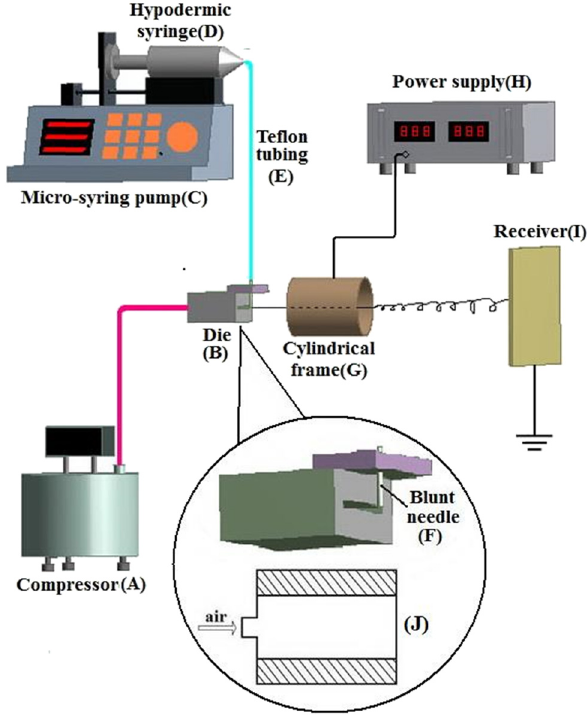
Figure 1: Schematic of CSBS setup ( 25 ) : ( A ) compressor, ( B ) die, ( C ) micro - syringe pump, ( D ) hypodermic syringe, ( E ) te fl on tubing, ( F ) blunt needle, ( G ) cylindrical frame, ( H ) power supply, ( I ) receiver, ( J ) cross section of the